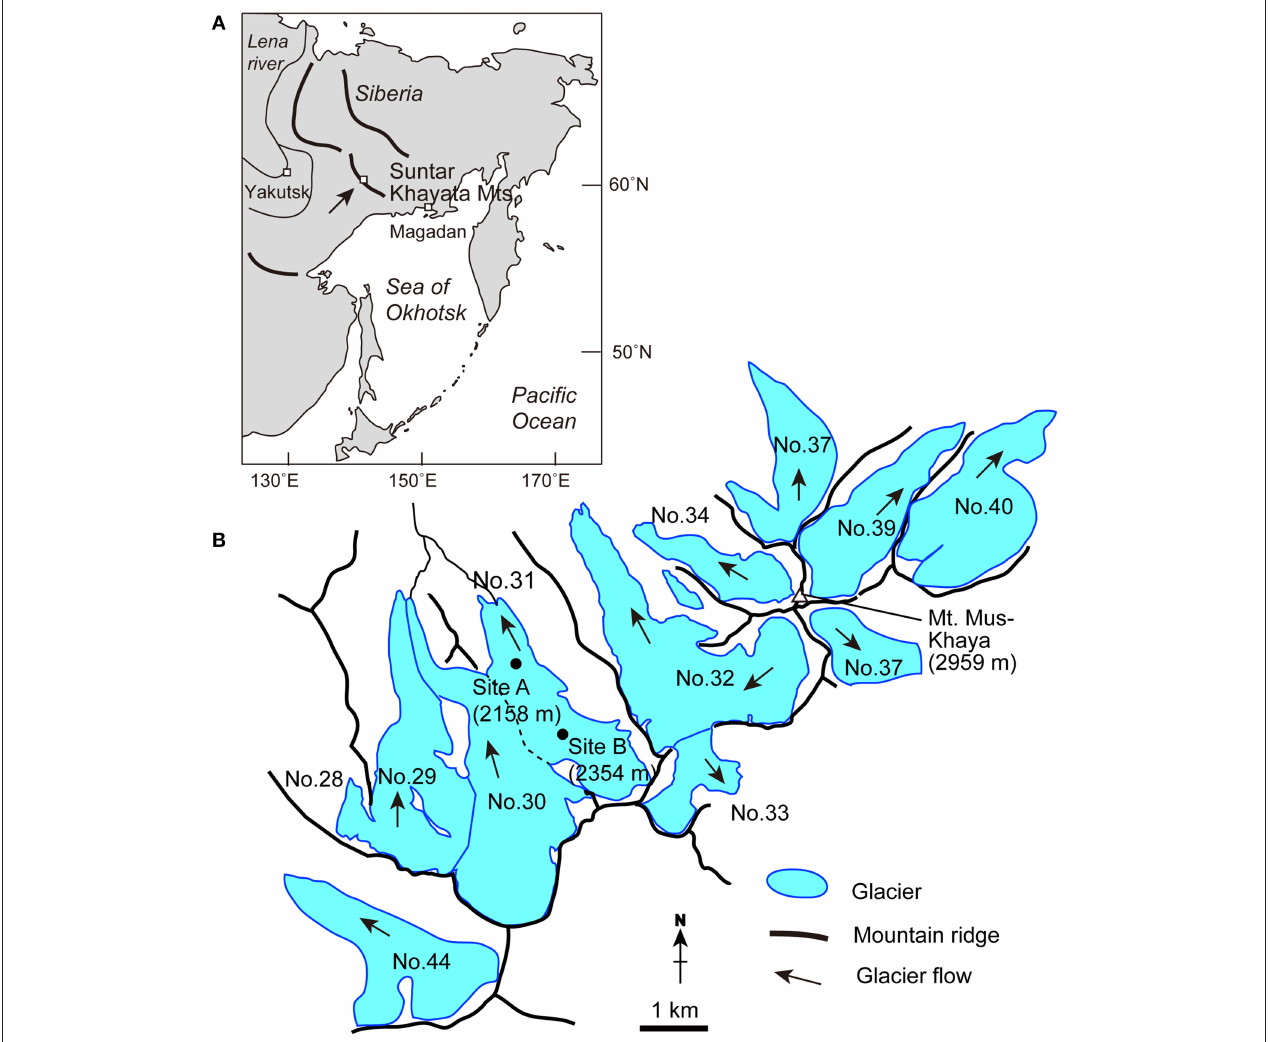
FIGURE 1 | Maps detailing (A) the location of Suntar-Khayata Range in Eastern Siberia, and (B) the locality and study sites on Glacier No. 31 and surrounding glaciers in the